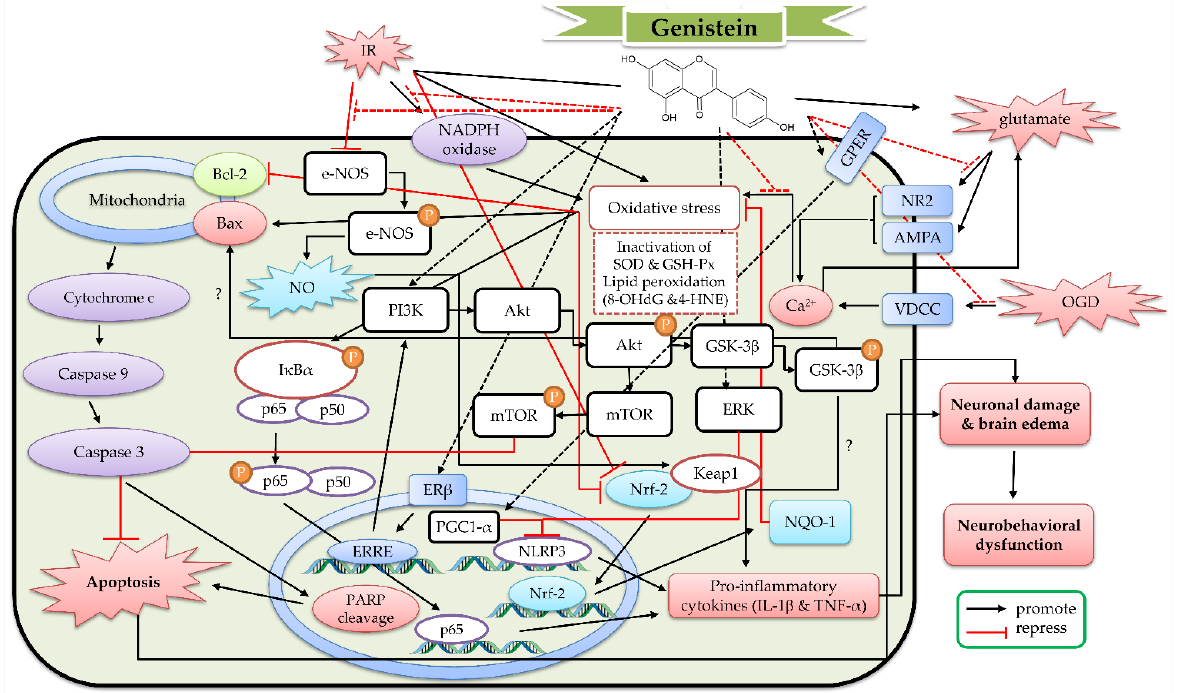
Figure 5. The protective effects of genistein and genistin against cerebral ischemia reperfusion (IR). 4-HNE, 4-hydroxynonenal; 8-OHdG, 8-hydroxy-2-deoxyguanosine; Akt, protein kinase B; AMPA, α -amino-3-hydroxy-5-methyl-4-isoxazolepropionic acid; Bax, Bcl-2-associated X protein; Bcl-2, B-cell lymphoma 2; eNOS, endothelial nitric oxide synthase; ER β , estrogen receptor β ; ERRE, estrogen-related receptor response element sites; GPER, G protein-coupled estrogen receptor; GSH- Px, glutathione peroxidase; GSK-3 β , glycogen synthase kinase 3 β ; I κ B α , Inhibitor kappa B; IL- 1 β , interleukin-1 β ; IR, ischemia reperfusion; Keap1, Kelch-like ECH-associated protein 1; mTOR, mammalian target of rapamycin; NADPH, nicotinamide adenine dinucleotide phosphate; NLRP3, NOD-like receptor protein 3; NO, nitric oxide; NR2, N-methyl-D-aspartate receptor 2; NQO-1, NAD (P)H: quinone oxidoreductase-1; Nrf-2, nuclear factor erythroid 2-related factor 2; OGD, oxygen and glucose deprivation; PARP, Poly (ADP-ribose) polymerase; PGC-1 α , peroxisome proliferator- activated receptor-gamma coactivator 1 α ; PI3K, phosphatidylinositol 3-kinase; ROS, reactive oxygen species; SOD, superoxide dismutase; TNF- α , tumor necrosis factor α ; VDCC, voltage-dependent calcium